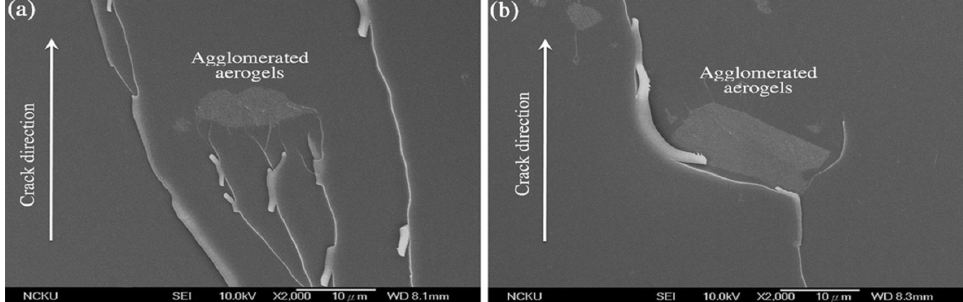
Figure 16. FEG-SEM images of the fracture surfaces of a composite with a carbon aerogel content of 0.5 wt %. The surfaces show (a) crack pinning and (b) crack deflection [82] .